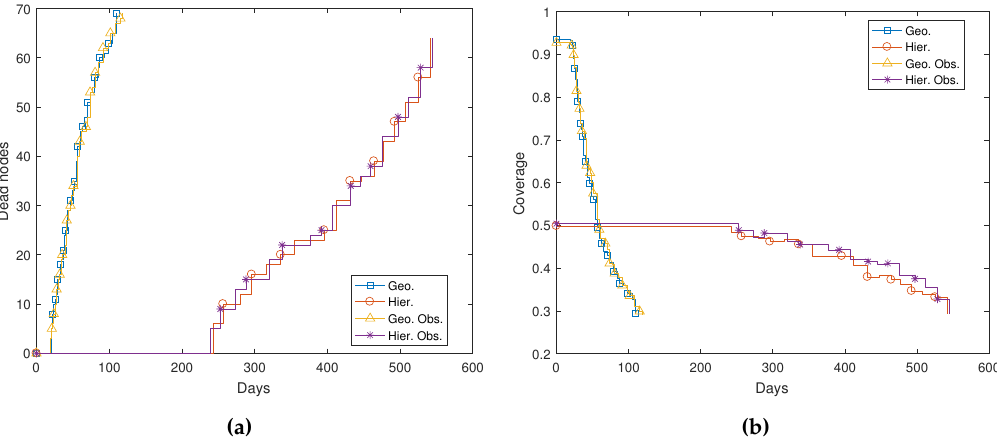
Figure 13. Network evolution in time: ( a ) dead nodes; ( b ) coverage.